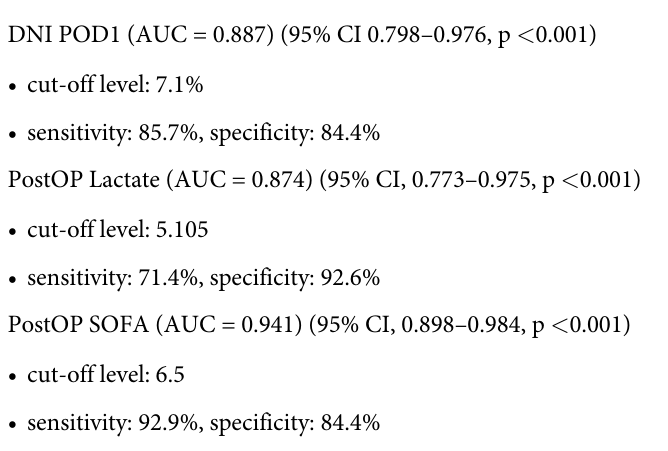
score on the ICU admission, and DNI on the POD1 were 5.105 mmol/L (sensitivity: 71.4%, specificity: 92.6%), 6.5 (sensitivity: 92.9%, specificity: 84.4%), and 7.1% (sensitivity: 85.7%, specificity: 84.4%), respectively (Fig 3).